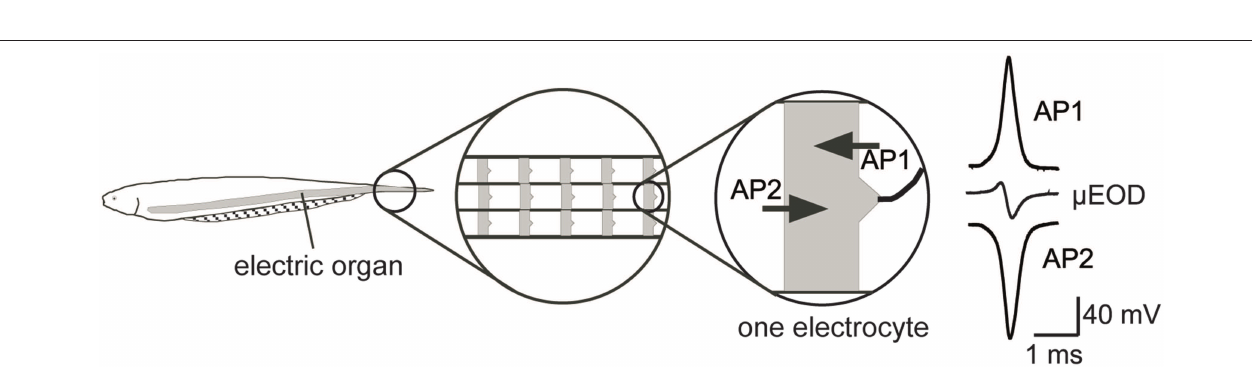
FIGURE 7 | (A) B. occidentalis from streams in Panama with lower incidence of piscivorous catfish (red line) produced EODs with a more-extended second phase than animals in streams with high incidence of catfish (blue line). (B) The power spectra of a typical EOD from a low-catfish stream (red line) has more energy in the spectral range of ampullary electroreceptors than the EOD of a male from a high catfish stream (blue line).